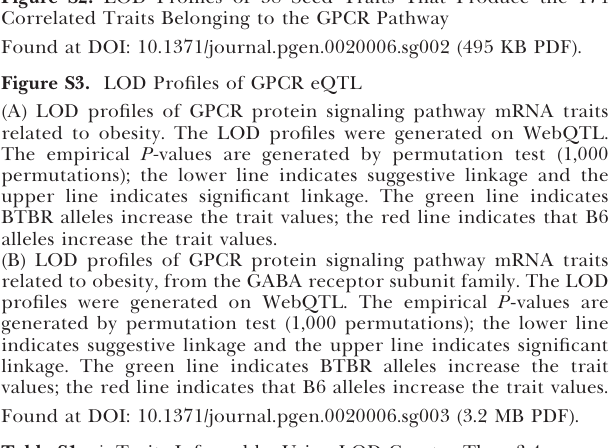
Figure S1. LOD Profiles of ATP Synthase Subunit mRNA Traits The traits exhibiting a linkage peak on Chromosome 2 are grouped together on top rows. Found at DOI: 10.1371/journal.pgen.0020006.sg001 (477 KB PDF). Figure S2. LOD Profiles of 38 Seed Traits That Produce the 174 Correlated Traits Belonging to the GPCR Pathway Found at DOI: 10.1371/journal.pgen.0020006.sg002 (495 KB PDF). Figure S3. LOD Profiles of GPCR eQTL (A) LOD profiles of GPCR protein signaling pathway mRNA traits related to obesity. The LOD profiles were generated on WebQTL. The empirical P- values are generated by permutation test (1,000 permutations); the lower line indicates suggestive linkage and the upper line indicates significant linkage. The green line indicates BTBR alleles increase the trait values; the red line indicates that B6 alleles increase the trait values. (B) LOD profiles of GPCR protein signaling pathway mRNA traits related to obesity, from the GABA receptor subunit family. The LOD profiles were generated on WebQTL. The empirical P -values are generated by permutation test (1,000 permutations); the lower line indicates suggestive linkage and the upper line indicates significant linkage. The green line indicates BTBR alleles increase the trait values; the red line indicates that B6 alleles increase the trait values. Found at DOI: 10.1371/journal.pgen.0020006.sg003 (3.2 MB PDF). Table S1. cis Traits Inferred by Using LOD Greater Than 3.4 Columns A, B, and C show the Affymetrix probe set IDs, gene names, and the gene symbols of the cis traits. Columns D and E show the physical chromosome and position (Mb) of the traits. Column F shows the maximum LOD scores of the cis traits. Found at DOI: 10.1371/journal.pgen.0020006.st001 (46 KB TXT). Table S2. Enriched GO Categories for Expression Traits That Are Correlated with the Seed Traits Using each of the 6,016 transcripts as a seed, Pearson correlation coefficients were calculated against the log-transformed expression intensities (raw intensities were normalized by RMA) of all of the 45,037 transcripts in the 60 F 2 mice. For each seed, we collected the traits with correlation coefficients of 0.7 or greater, which form the list of correlated traits for that seed. Enriched functional groups, defined as GO categories corresponding to BP, were identified from each list with P- values computed using a custom variant of ‘‘ GOHyperG ’’ in the ‘‘ GOstats ’’ package (Bioconductor Core Team 2004; http://www.bioconductor.org). For each list, we examined up